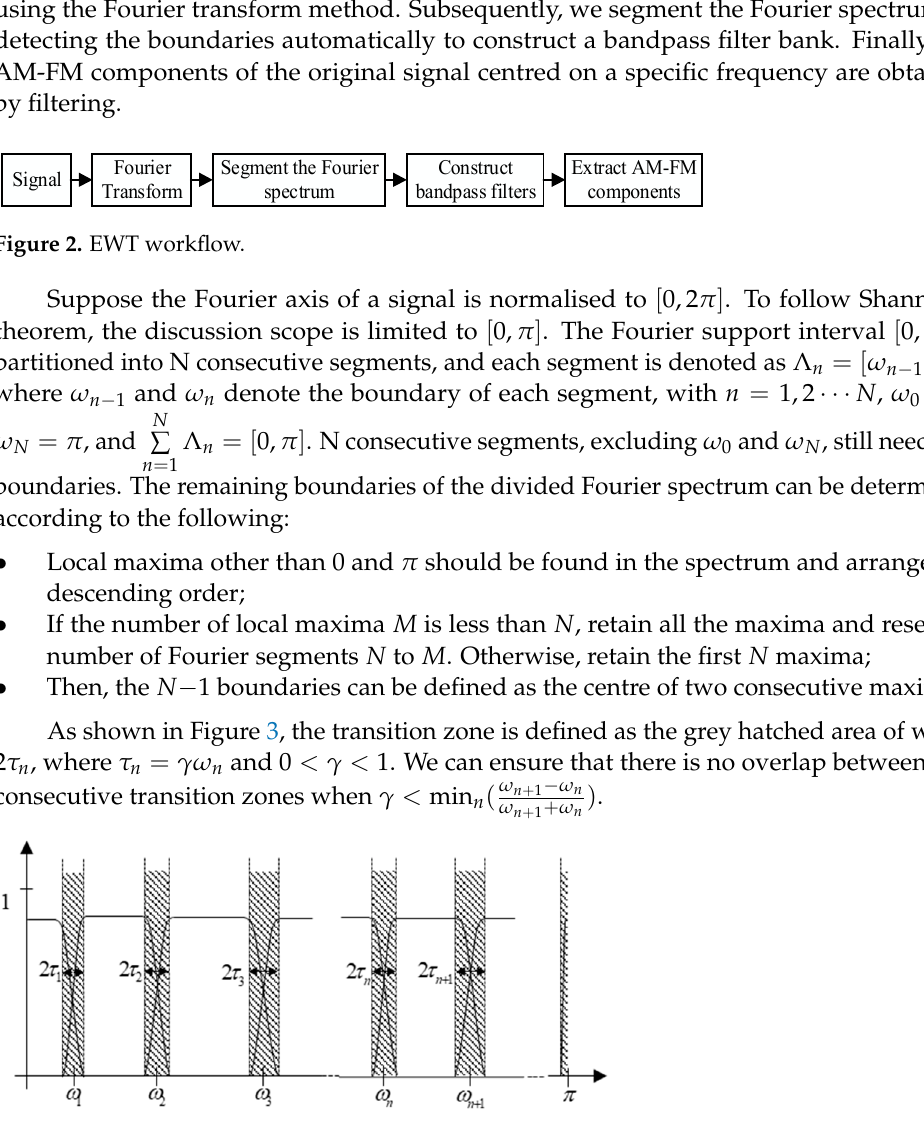
Figure 3. Segmentation of the Fourier spectrum.